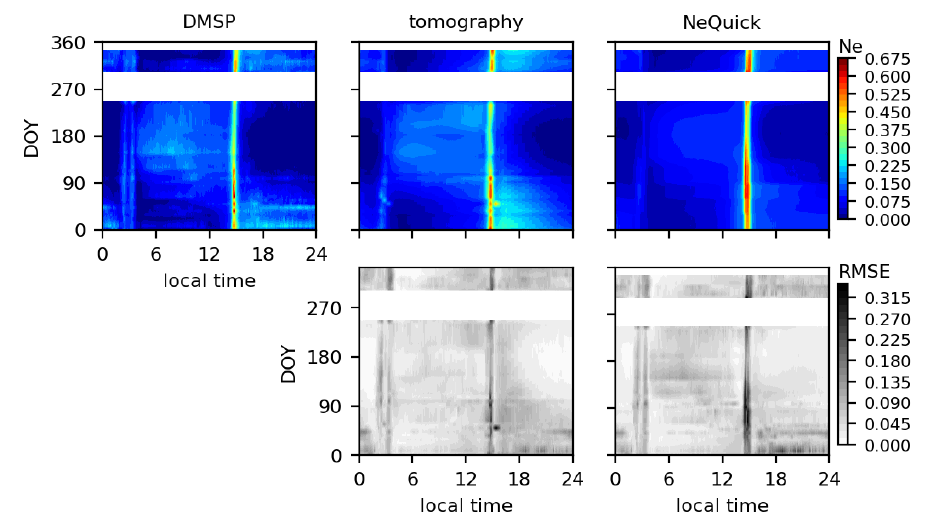
Figure 10. Electron density and RMSE distributions during 2018 obtained with DMSP number 15, NeQuick and tomography. The electron density Ne (el/m 3 ) was estimated based on a daily average in terms of local time. White spaces are referred to the lack of DMSP or COSMIC